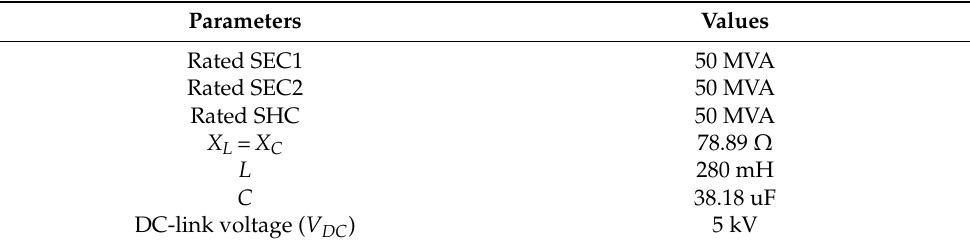
Table 1. Parameters of UIPC.